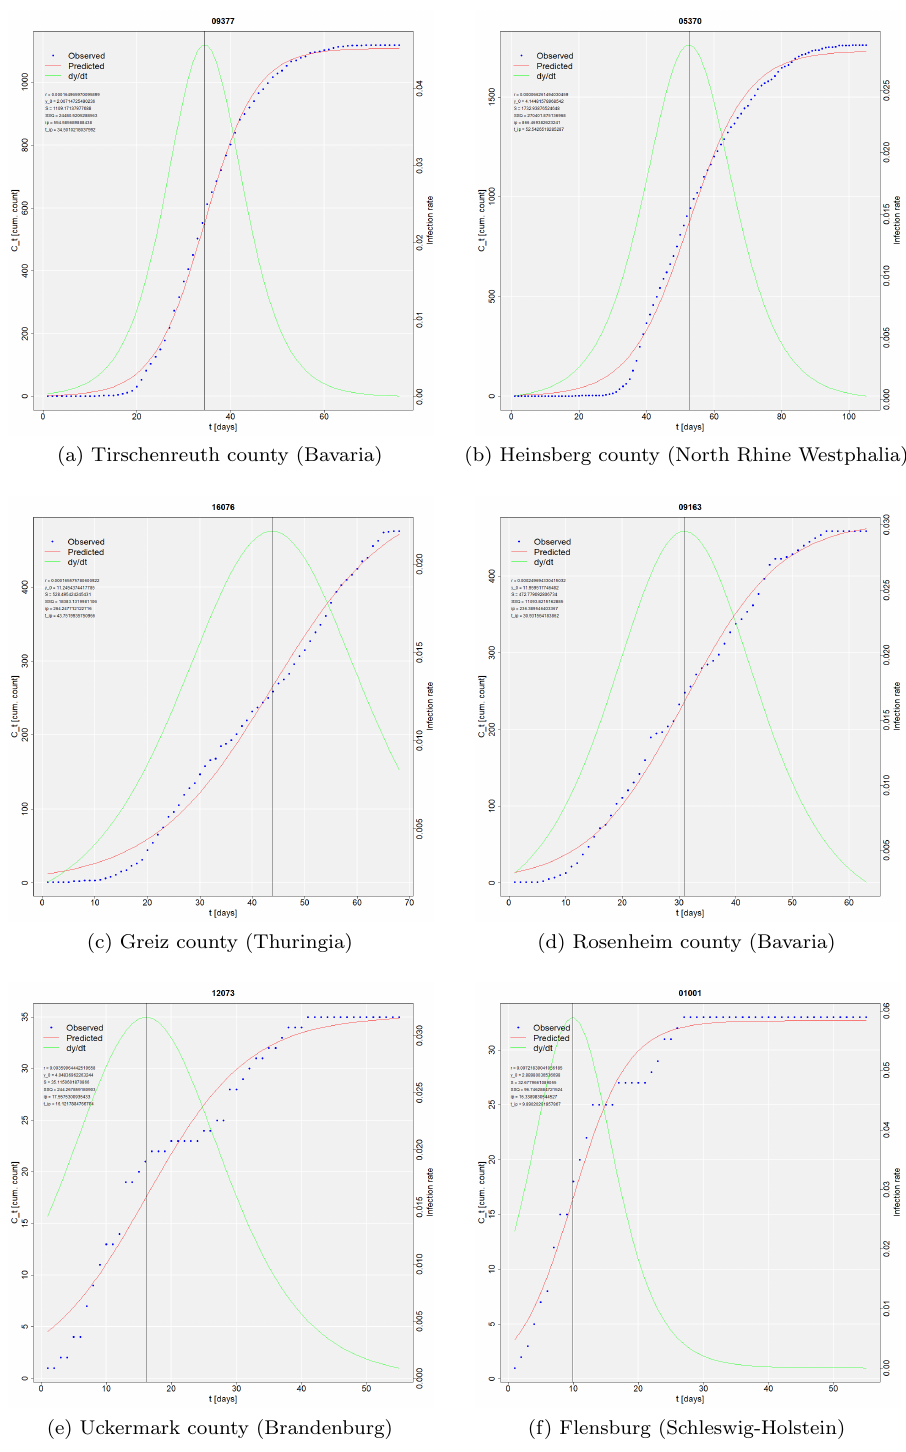
Figure 6: Cumulative SARS-CoV-2 infections (based on estimated dates of infection) and estimated logistic growth models (including infection rate and inflection point) in six German